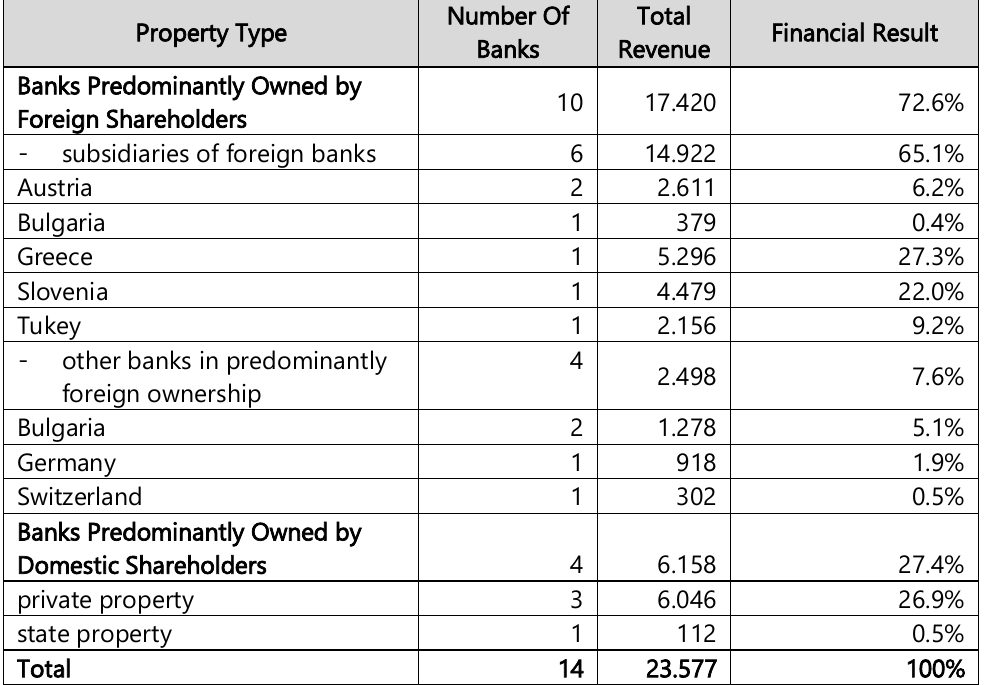
Table 1: Structure of the Banks in North Macedonia and their Total Income (Source: NBRNM